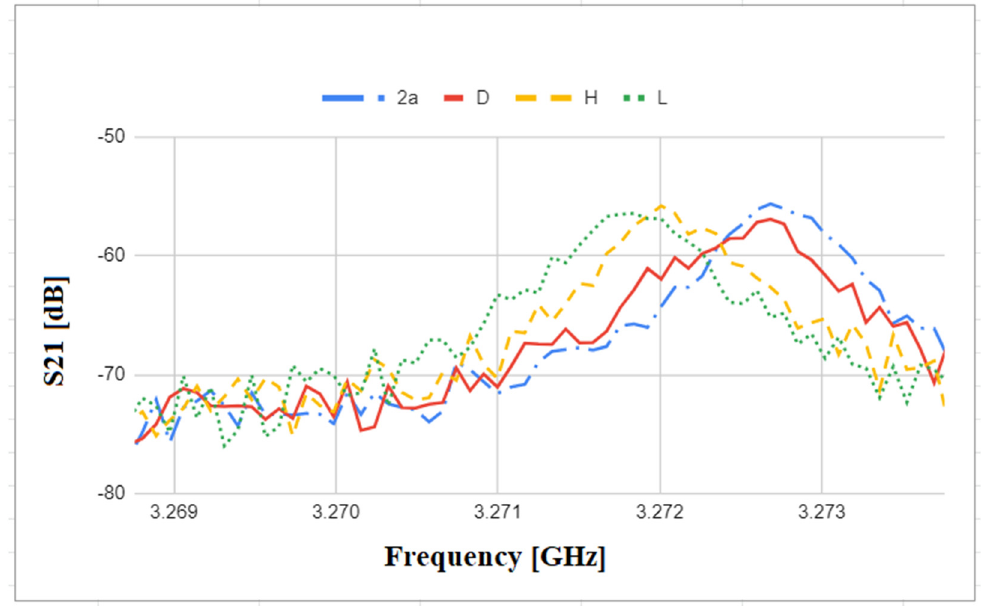
Figure 18. Location of the peaks of the master diamonds at 3.27 GHz.